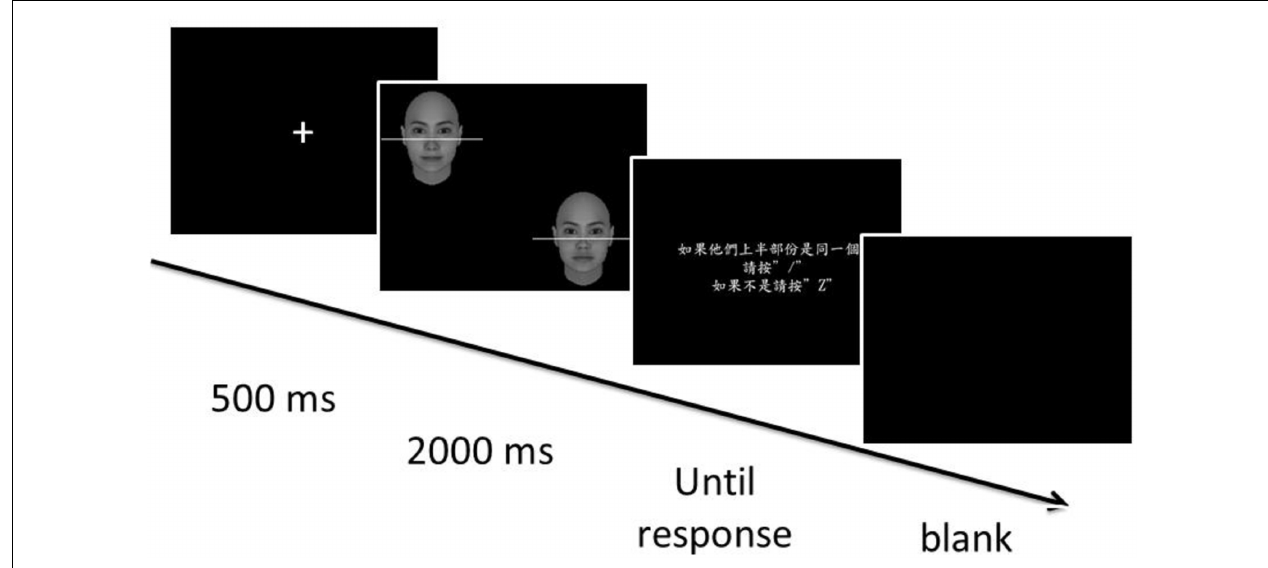
FIGURE 3 | Illustration of events in a single trial for Experiment